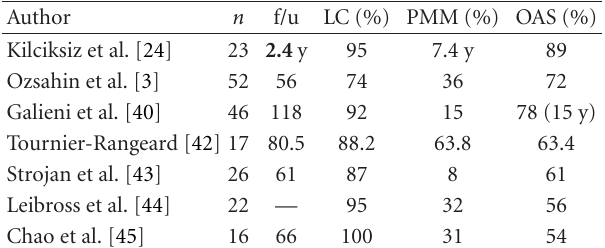
Table 1: Solitary plasmacytoma of bones: representative treatment results.